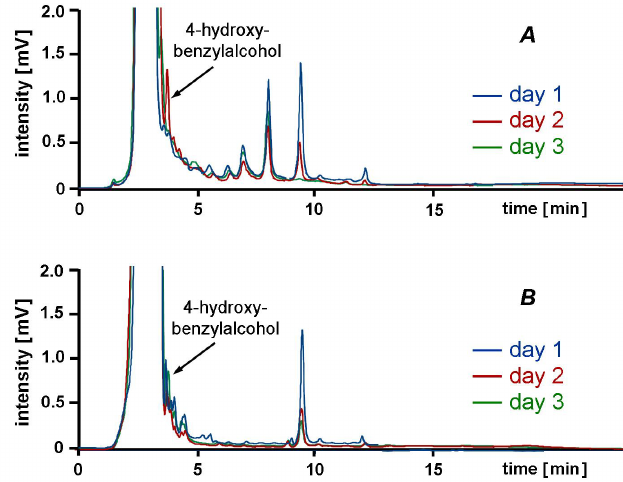
Fig. 6: Variation of degradation products pattern in M. oleifera cold extracts. A: Dried leaf powder; B: fresh crushed leaves. Directly after homogenization with tap water, the samples had been stored at 4 °C. For detection, a diode array detector was employed ( ʎ = 220 nm). Due to the HPLC conditions, in contrast to the LC-MS analyses mentioned above, glycosylated compounds, e.g. all gluco - sinolates, elute in the void volume.